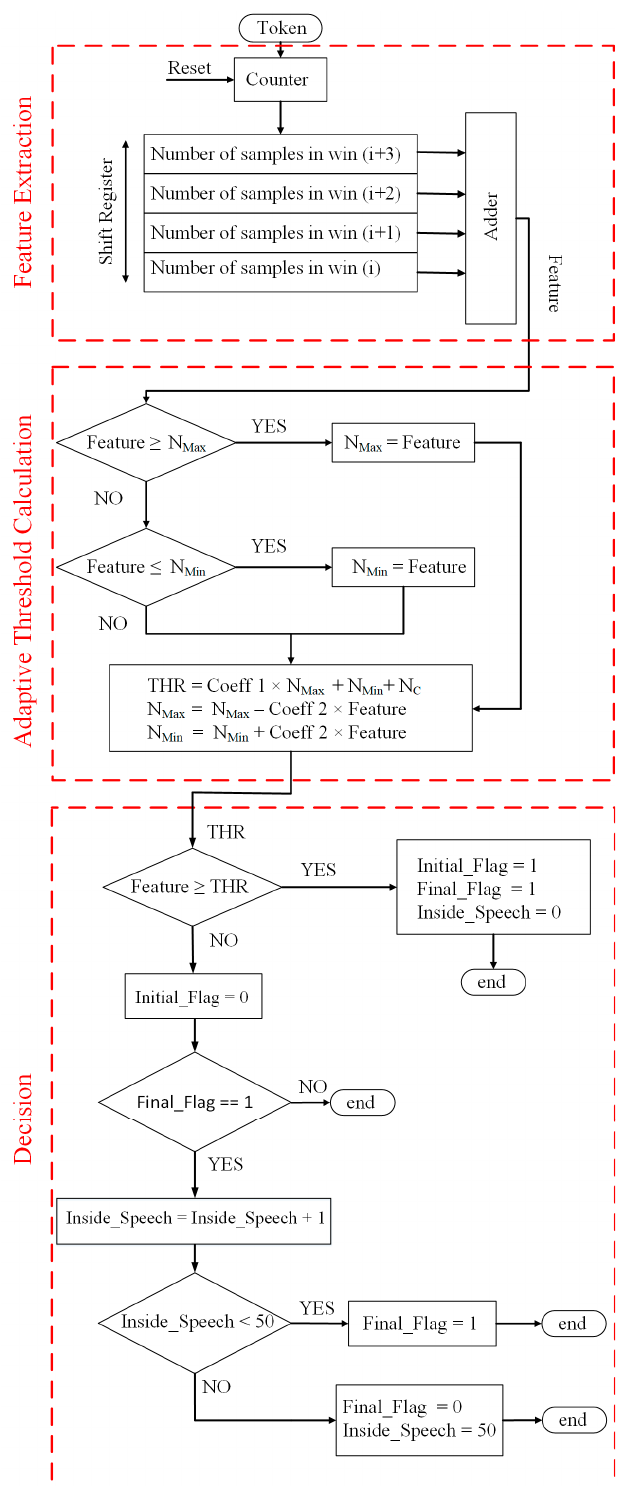
Figure 7. Flowchart of the proposed VAD algorithm containing the feature extraction, adaptive threshold calculation, and decision blocks.